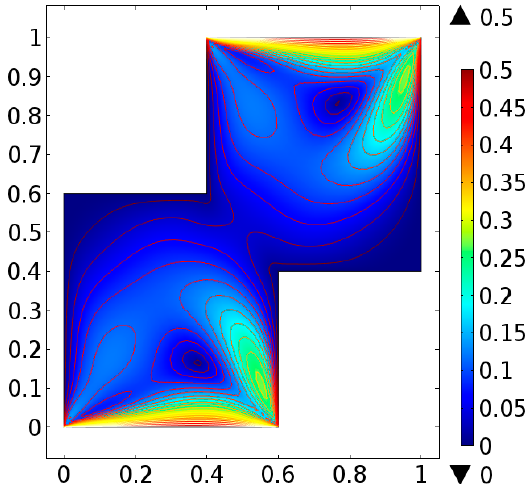
Figure 23. Velocity distribution at Re = 400 for case-II.